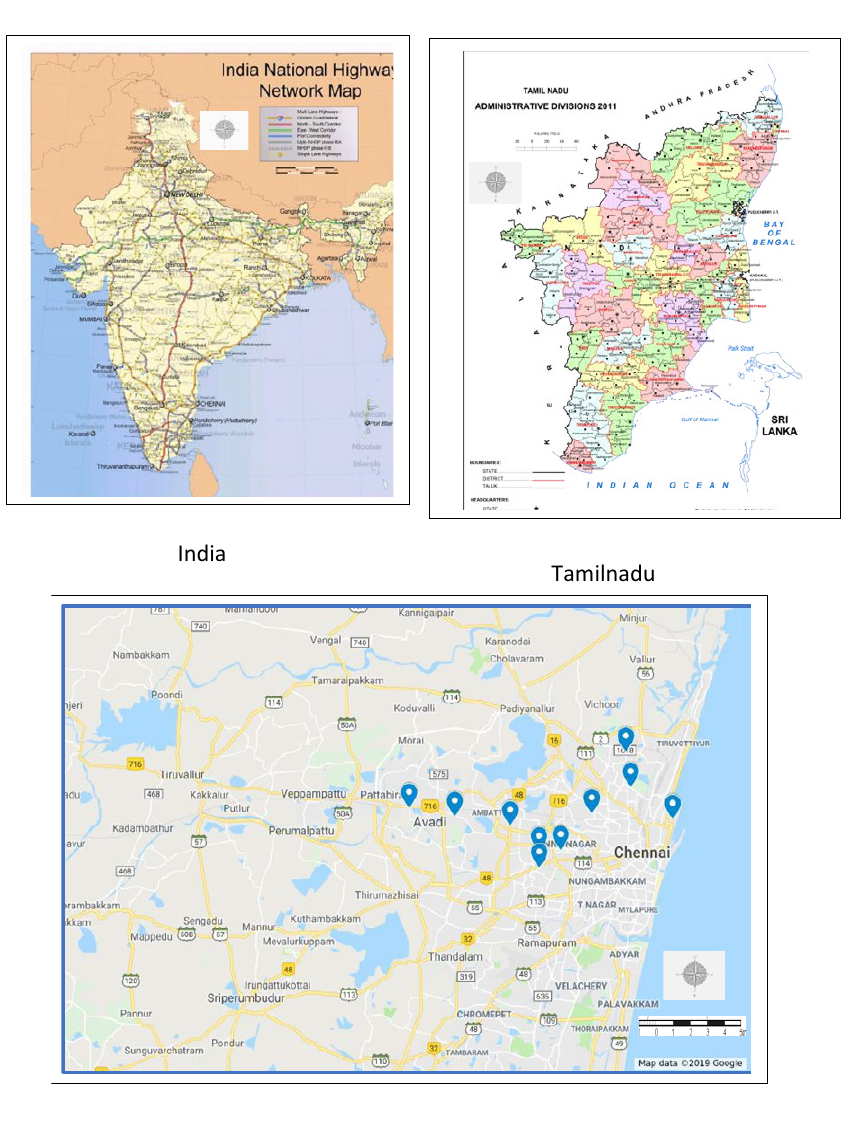
Fig. 2: Study Area Map Showing the location of Air Quality